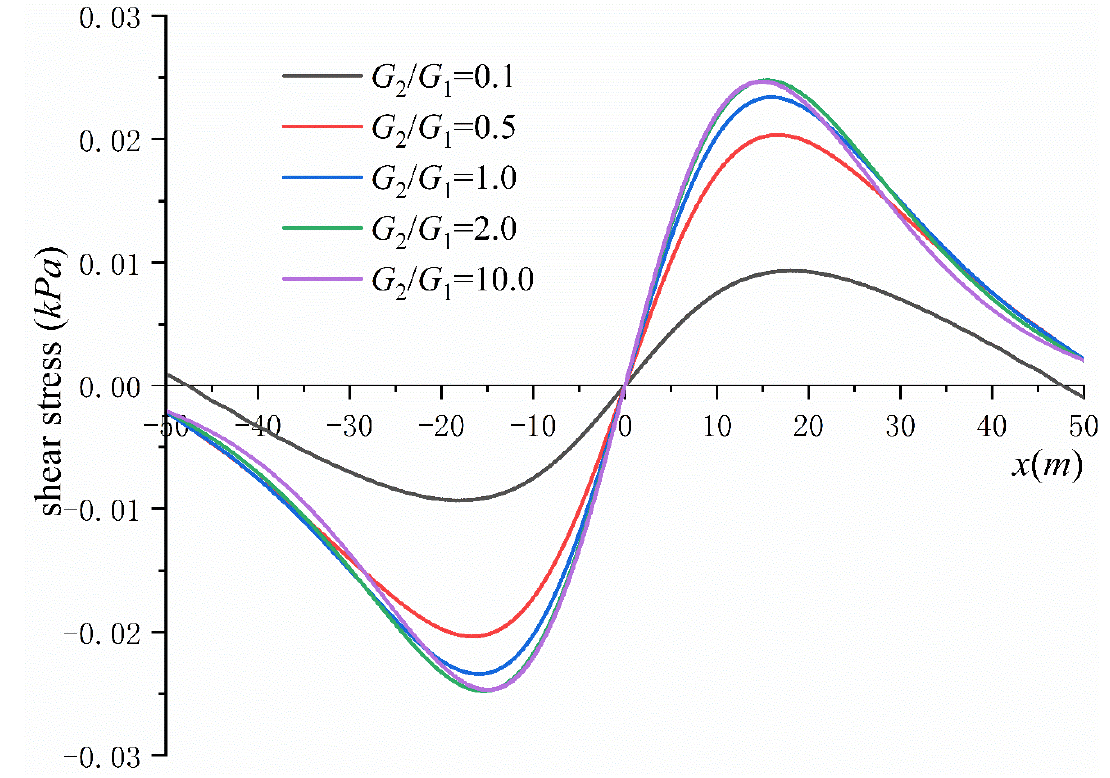
Figure 14. Effect of layered soil on shear stress at interface.